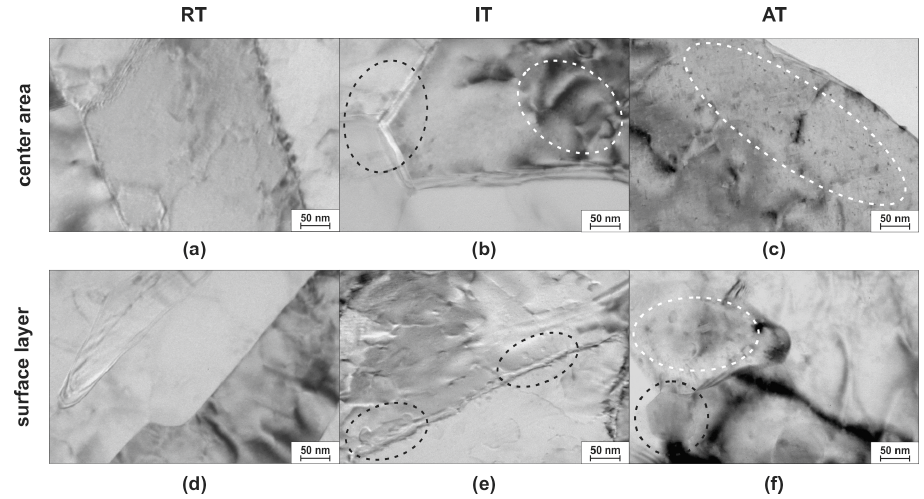
Figure 3. Transmission electron microscopy (TEM) bright-field images taken from the center areas ( a – c ) and surface layers ( d – f ) of the extruded material. While room temperature (RT)-extrusion does not initiate dynamic precipitation, precipitates with diameters ranging from a few nanometers up to 80 nm were found both in the IT- and AT-extruded materials (areas containing precipitates are highlighted by white and black ellipses).